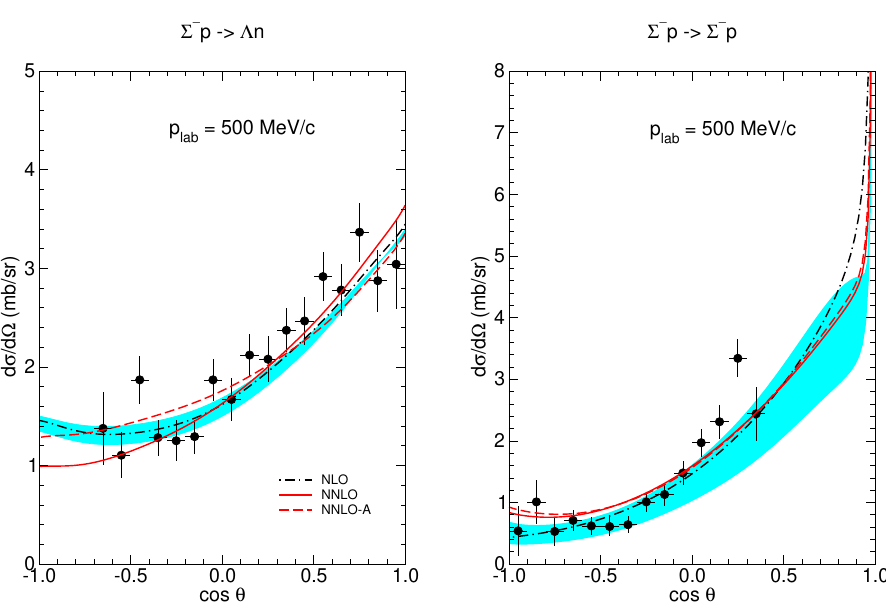
Figure 3. Di ff erential cross sections for Σ − p → Λ n and Σ − p → Σ − p . Same description of curves as in Fig. 1. Data are from the E40 Collaboration [21, 22] (momentum region 470-550 MeV /